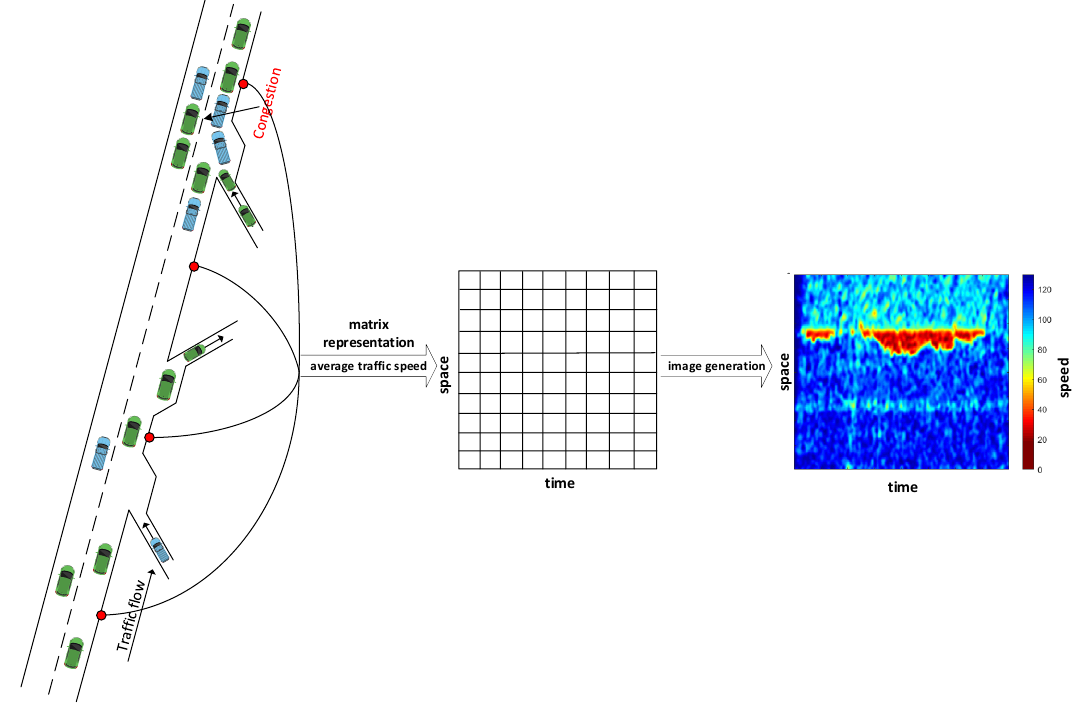
Figure 7. Traffic-to-image conversion on an urban motorway